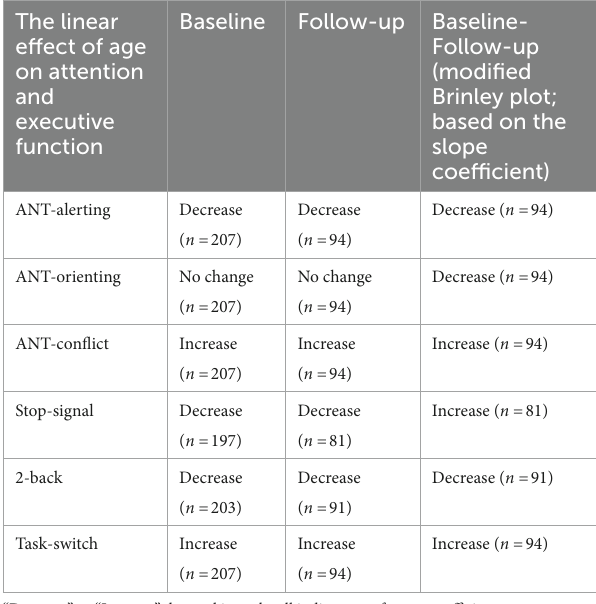
TABLE 2 Summary of the results for cognitive tasks in the baseline and follow-up test